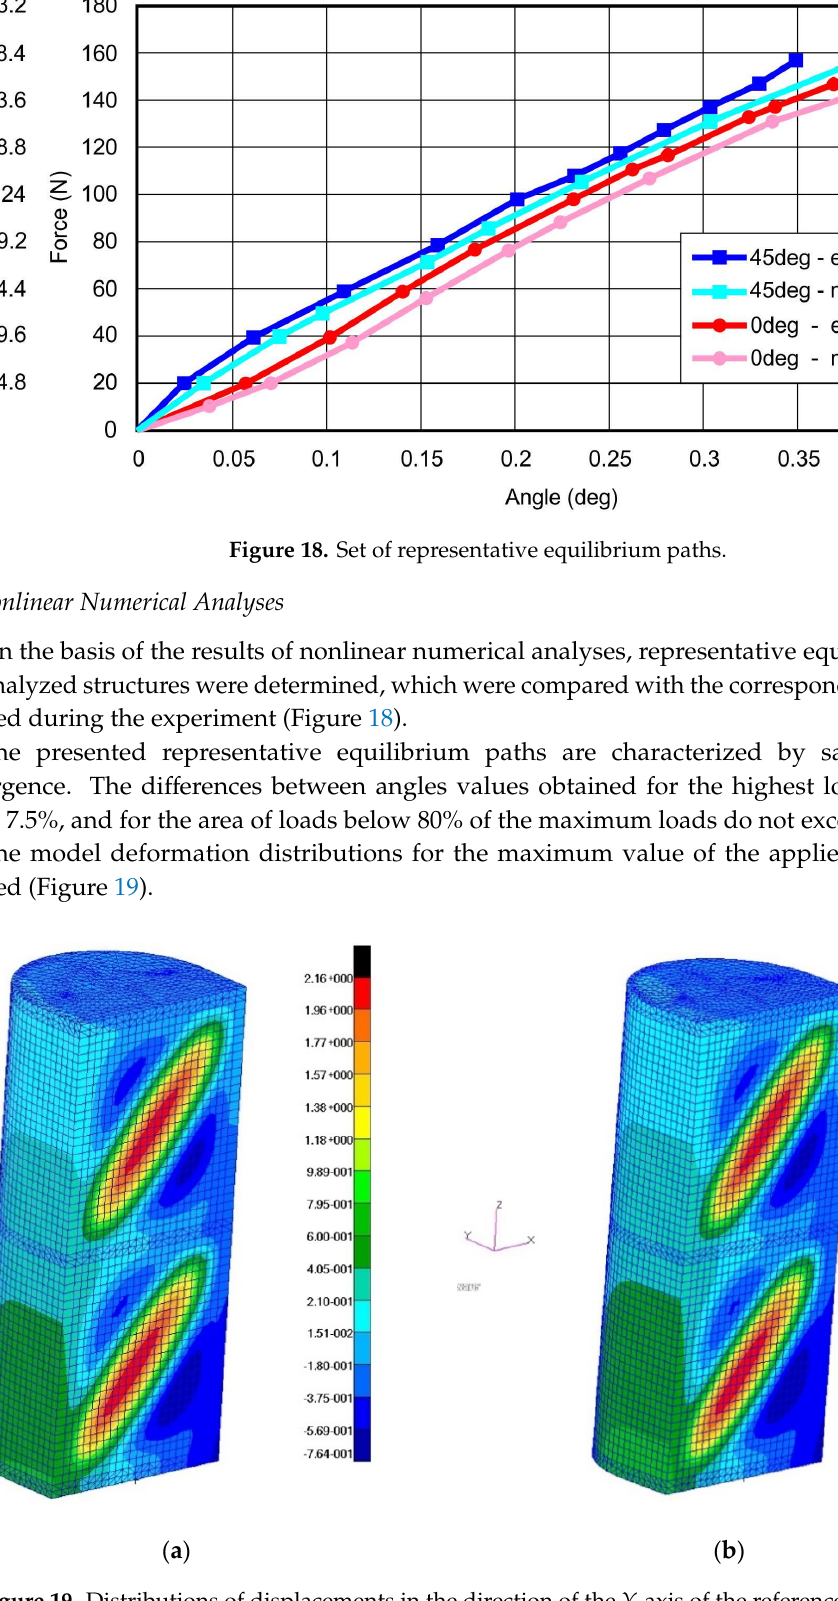
Figure 19. Distributions of displacements in the direction of the Y -axis of the reference system: ( a ) a wall with a fiber orientation corresponding to the X, Z directions; ( b ) a wall with fiber orientation at an angle of 45 degrees in relation to the X, Z directions.